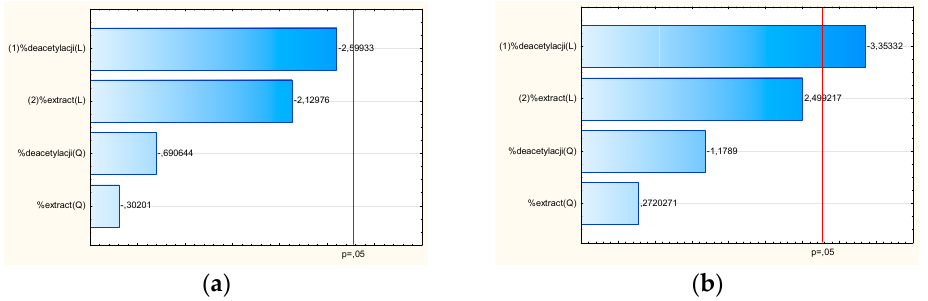
Figure 6. Pareto plot of standardized effects for the antioxidant activity using DPPH assay ( a ) and for anti-hyaluronidase activity ( b ) for chitosan systems.